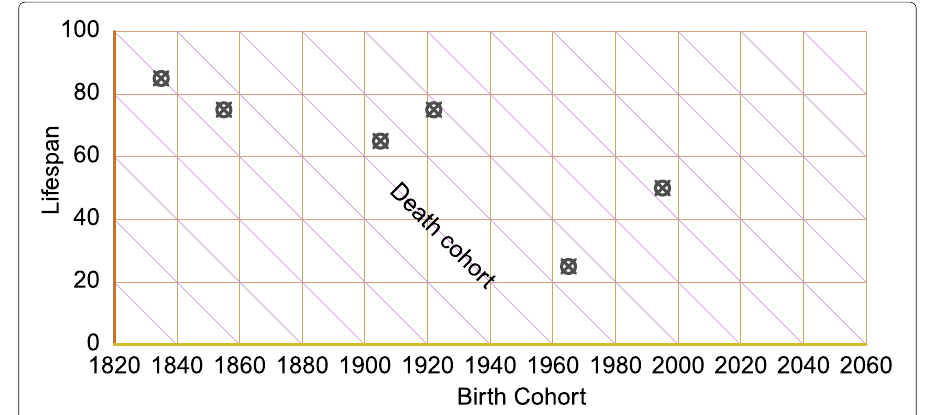
Fig. 4 An LCD diagram with six lifelines. Since the LCD plane is orthogonal to the life course, lifelines are depicted as